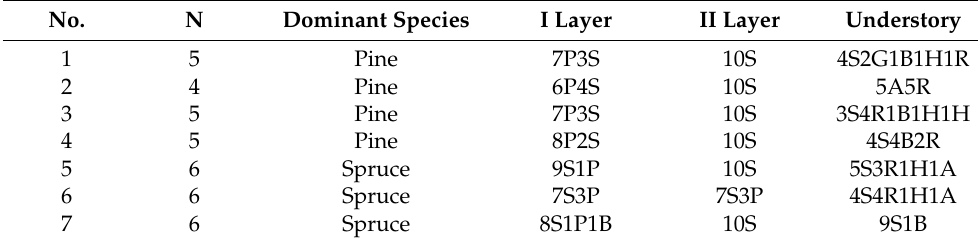
Table 1. Characteristics of sampled old-growth Scots pine and Norway spruce stands. No. N